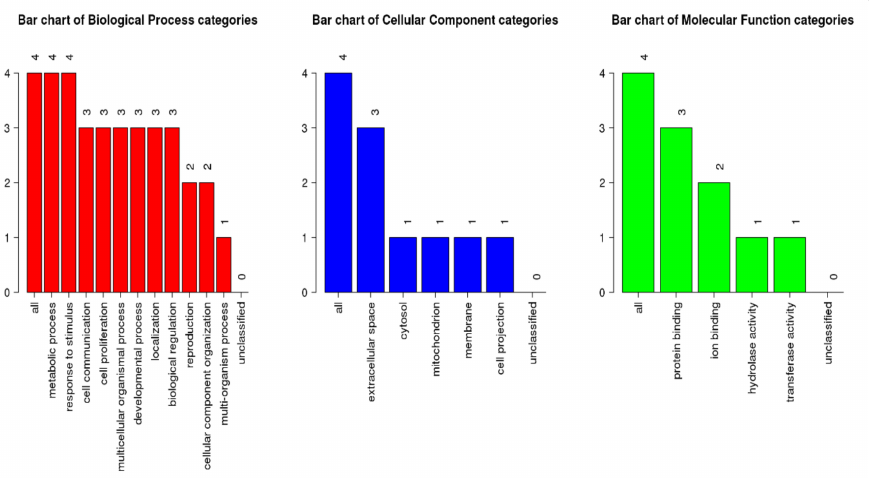
Figure 3. GOslim summary for the biological process, cellular component, and molecular function category for IL1A, ASAH2, IL5, and CRH proteins. Each of the functions is represented by a red, blue, and green bar, respectively.